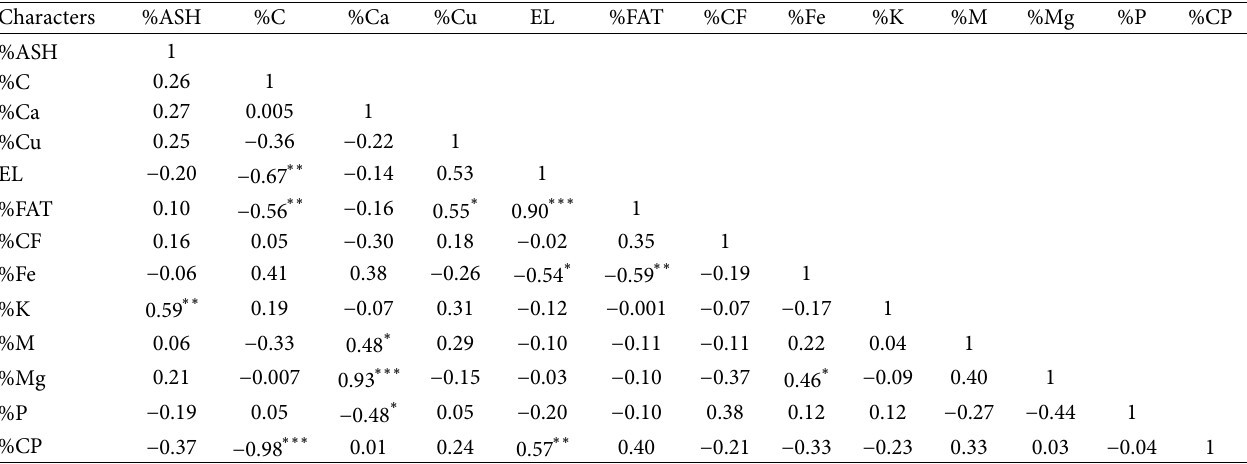
Table 5: Correlation matrix among biochemical characters at 5% and 1%